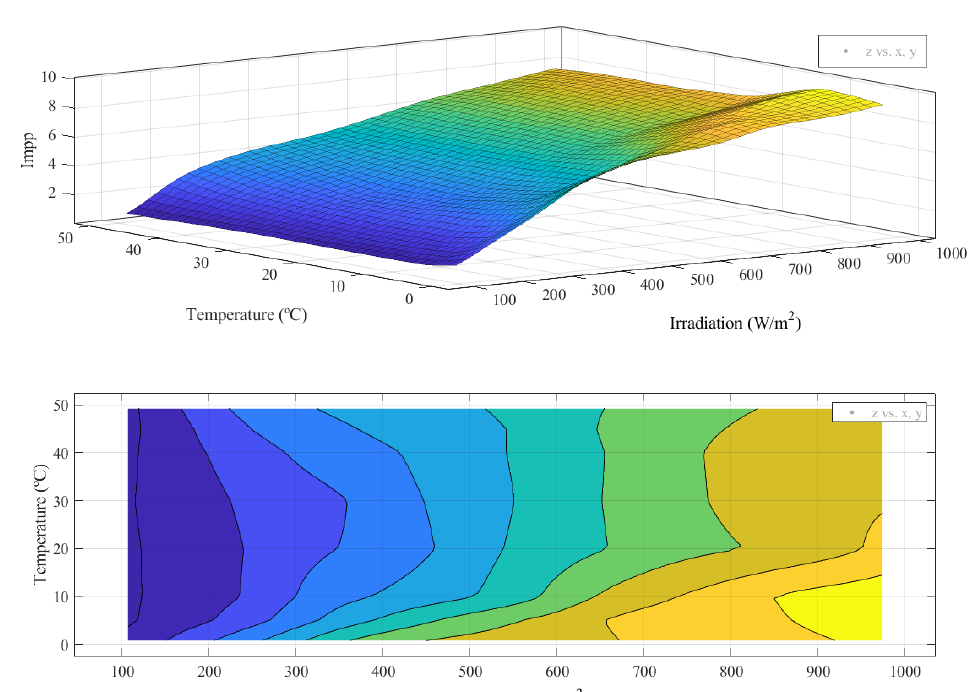
Figure 12. Irradiation − Temperature − Current characteristic surface of the